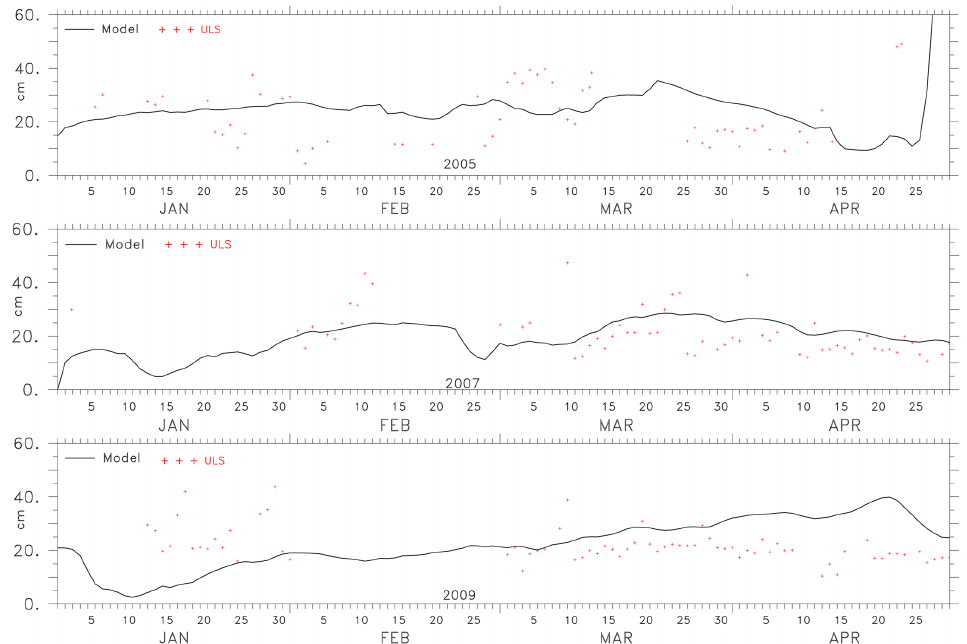
Figure 14. The level ice draft computed from the ULS measurement and the M2 model-estimated values at Makkovik Bank for 2005, 2007 and 2009.